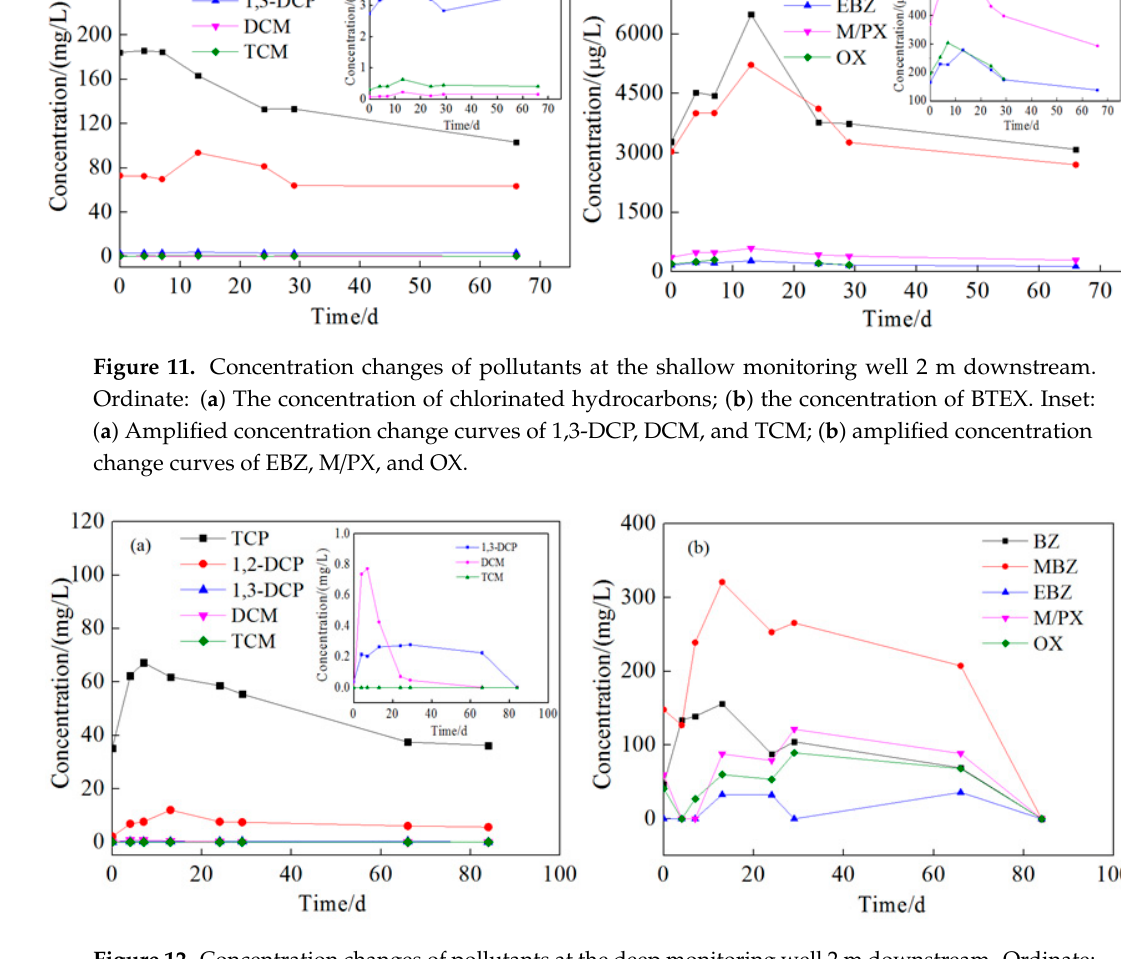
Figure 12. Concentration changes of pollutants at the deep monitoring well 2 m downstream. Ordinate: ( a ) The concentration of chlorinated hydrocarbons; ( b ) the concentration of BTEX. Inset: ( a ) Amplified concentration change curves of 1,3-DCP, DCM, and TCM.